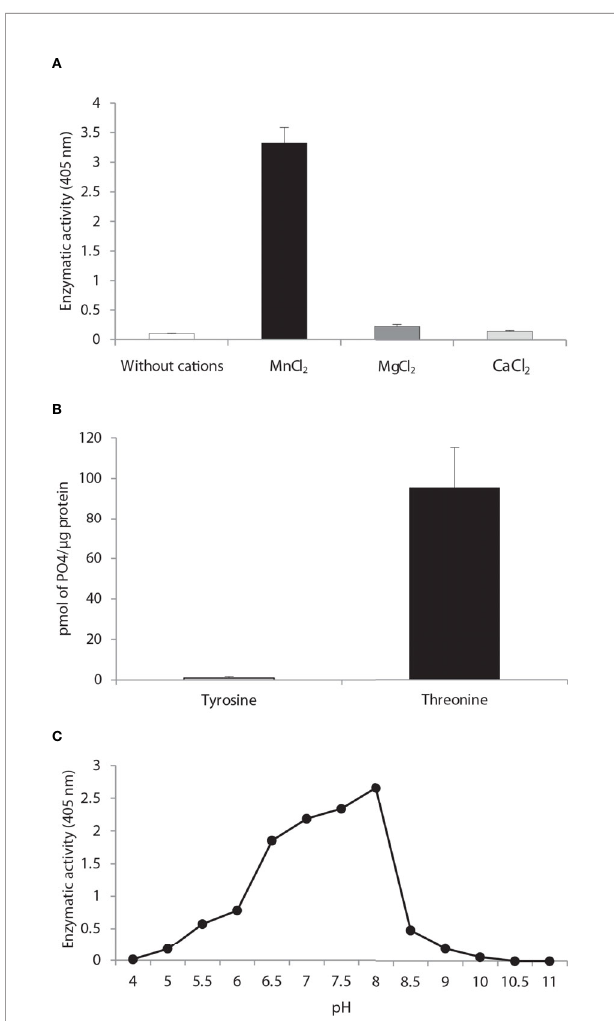
FIGURE 3 | Biochemical characterization of PP2C of Leishmania mexicana . (A) The effect of MgCl 2 , MnCl 2 and CaCl 2 on the activity of PP2C of L. mexicana ( Lmx PP2C) was measured under standard conditions with 10 mM p -NPP as the substrate. (B) Hydrolysis of [END (pY) INASL] and Thr [RRA (pT) VA] by LmxPP2C. (C) Determination of the optimal pH for the activity of Lmx PP2C, which was incubated with the appropriate buffers at different pH levels (4 – 11) in the presence of 10 mM MgCl 2 , with p-NPP as the substrate. Bars depict the mean percentage of relative activity of three independent